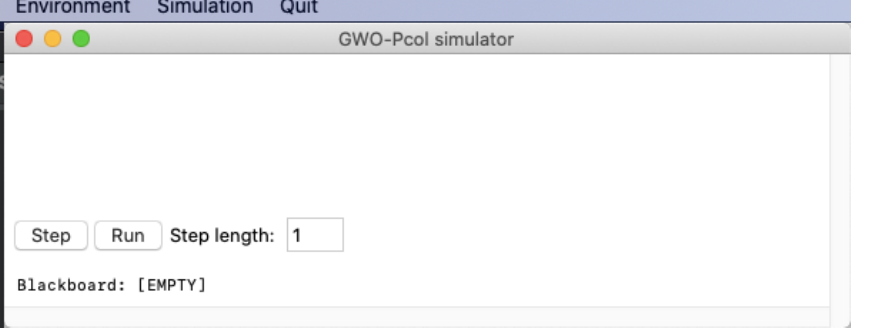
Figure 16. The main application window at